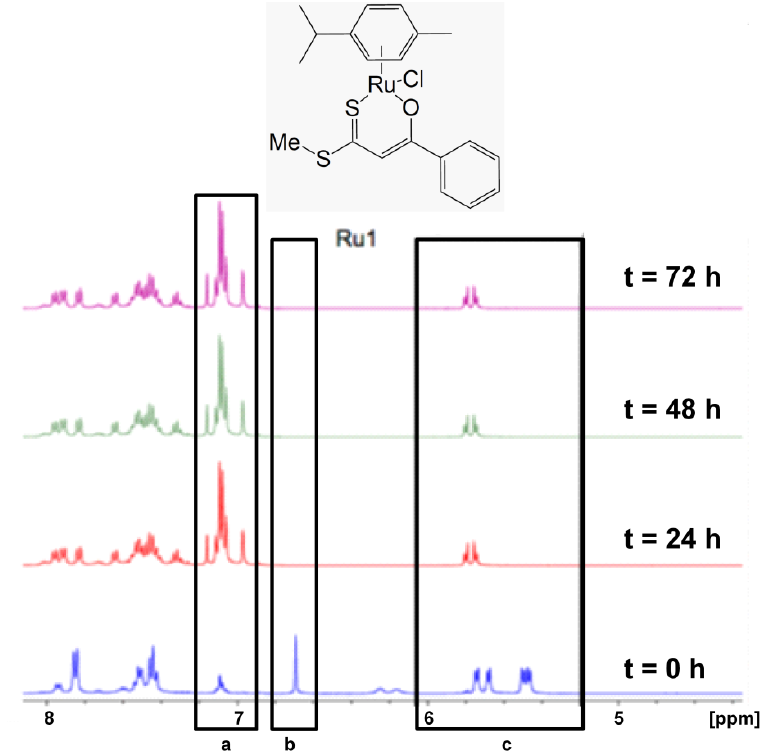
Figure 3. Overview of stability determination via 1H NMR spectroscopy for substance Ru1 at 37 °C for 72 h. Major detectable changes are boxed and labelled: ( a ) appearance of a new species, ( b ) disappearance of the methine proton, and ( c ) change of the double doublets of the cymene ligand. For a detailed overview of the spectral changes per hour, see Supplementary Figure S2.